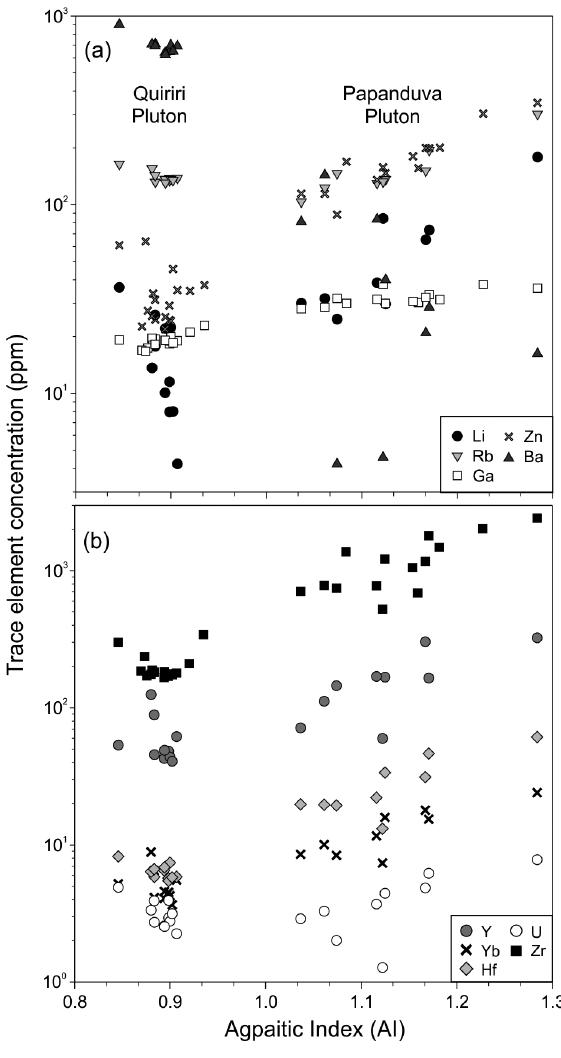
Figure 14 - Variation diagrams showing the behavior of selected LIL (a) and HFS (b) elements vs. AI for samples of the Quiriri and Papanduva Plutons, Morro Redondo Complex.